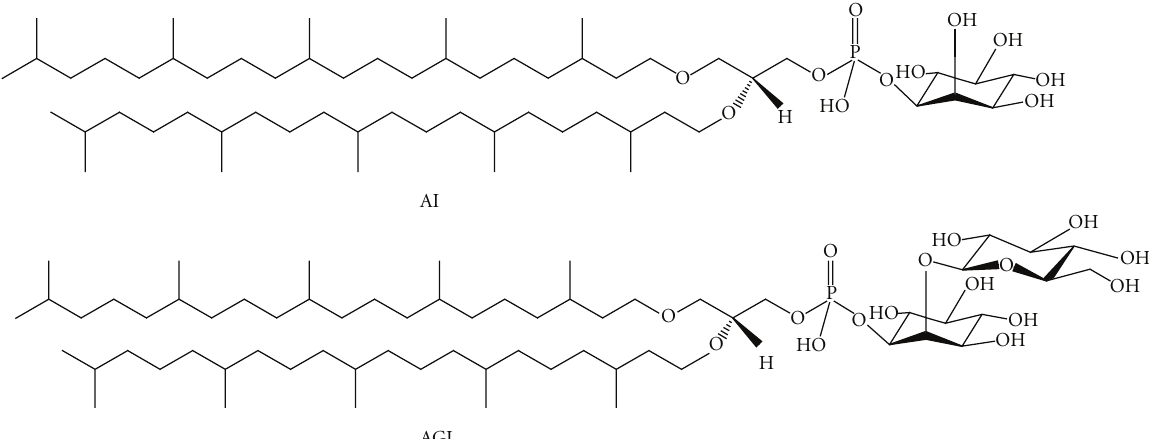
Figure 1: Structural formulas of 2,3-di- O -sesterpanyl- sn -glycerol-1-phospho-myo-inositol (C 25,25 -archetidylinositol) (top: AI) and